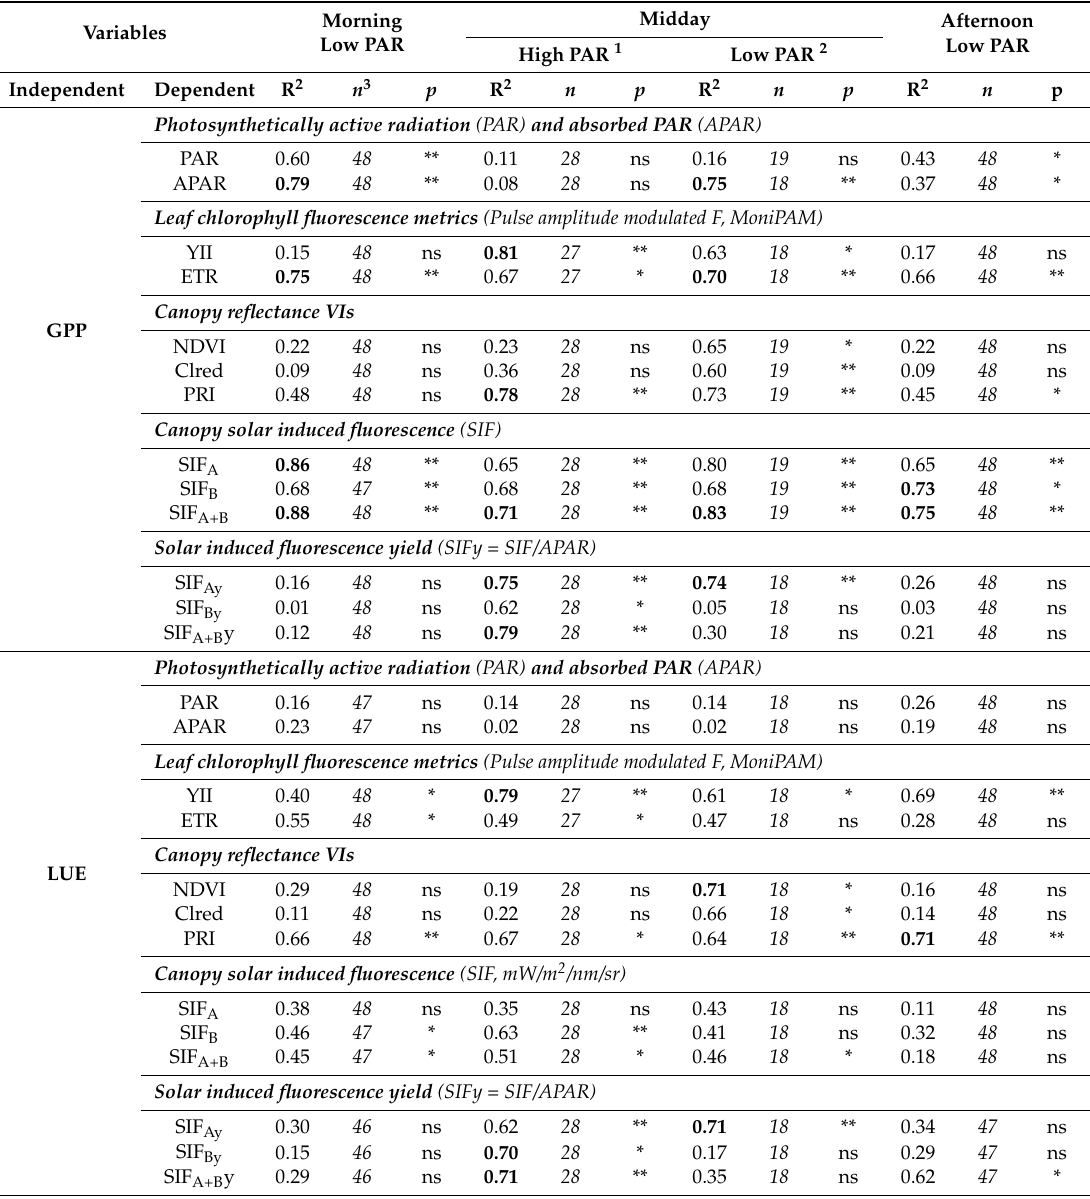
Table 4. Relationships to gross primary production (GPP) and to light use efficiency (LUE) of leaf-level PAM fluorescence metrics (i.e., operating efficiency of PSII or YII and electron transport rate, ETR), canopy-level reflectance indices (i.e., normalized difference vegetation index, NDVI; photochemical reflectance index, PRI; chlorophyll index, CI red ), and solar induced fluorescence (SIF) in the O 2 A (SIF A ) and O 2 B (SIF B ) bands and their total (SIF A+B ). The strength of the relationships was evaluated considering the time of observation and light level (i.e., below or above saturating for photosynthesis PAR, µ mol/m 2 /s), and the linear coefficients of determination (R 2 ) were